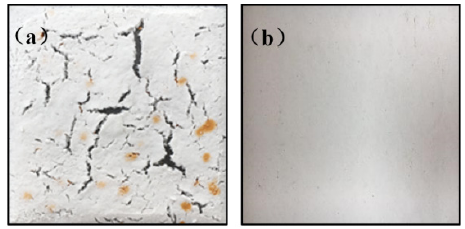
Figure 5. ( a ) coating morphology with only ceramic fibers (length was below 1 mm); ( b ) coating morphology with mixed fibers of different lengths (length was between 1–3 mm).